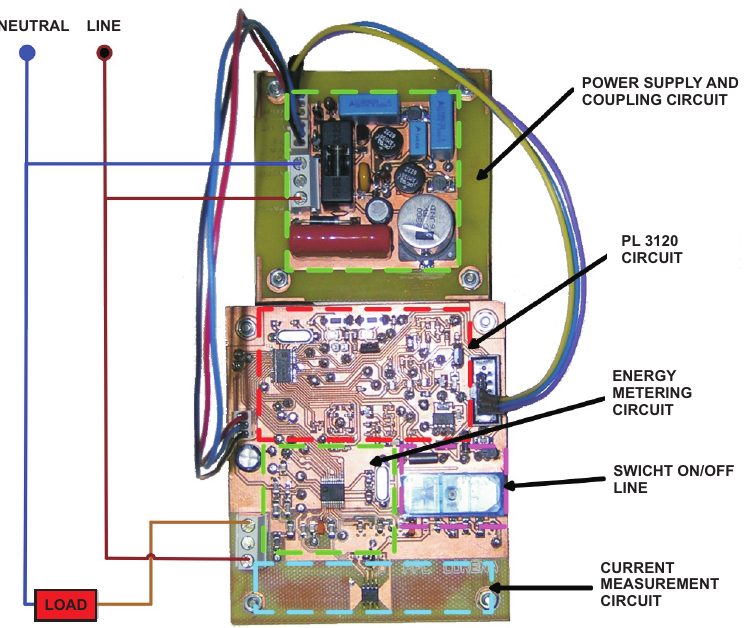
Figure 6. Setup to test the smart device.